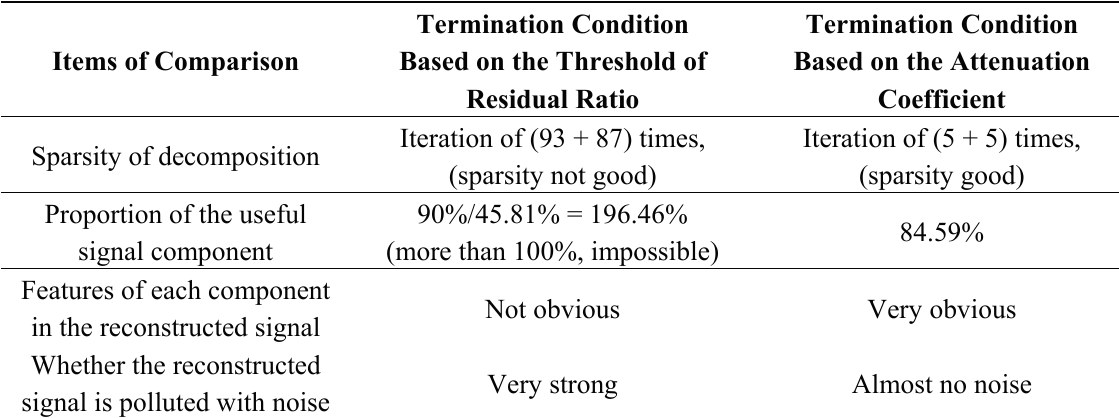
Table 1. Comparison results of different termination conditions of